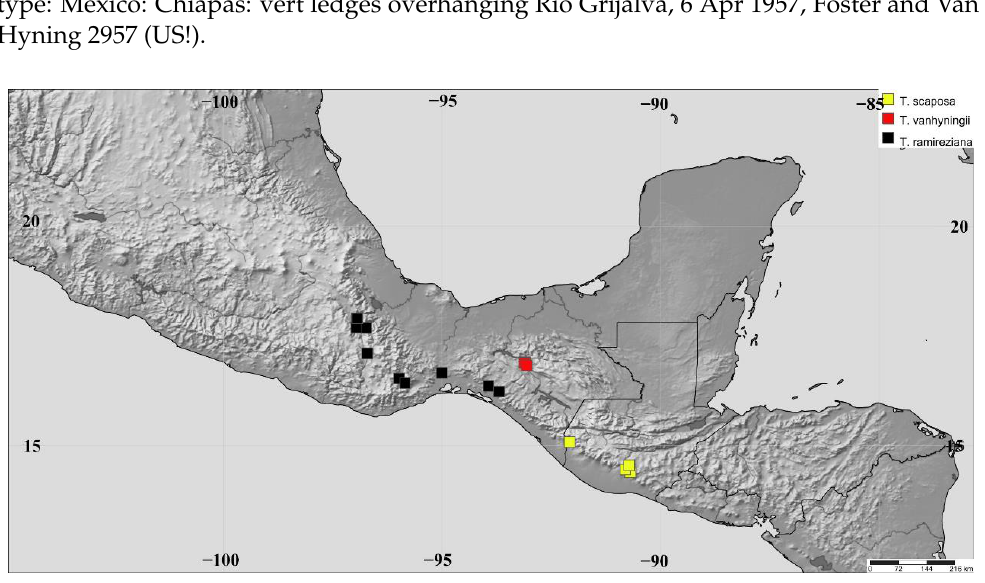
the rps16-trnQ marker sequences. Figure S4. Gene tree derived from StarBEAST analysis using the rpl16-rps3 marker sequences. Figure S5. Tree of maximum credibility of the BEAST analysis using three cpDNA molecular markers ( trnT-L-F , rps16-trnQ and rpl16-rps3 ) and the nDNA PHYC marker and each population as a putative lineage. Table S1. FST values for pairwise comparison between populations of the T. ionantha complex using cpDNA sequences. Table. S2. FST values for pairwise comparison between populations of the T. ionantha complex using nDNA sequences. Table S3. List of sequences generated in this study and deposited in GenBank. Table S4. Names and sequences of the primers used in this study and temperature conditions for PCR. * = Primers used in the amplification; + = Primers used in sequencing. References [22,57,81,82]. Length = Length after alignment; PS = Preserved Sites; VS = Variable Sites; PI = Parsimoniously Informative Sites; NSM = Nucleotide Substitution